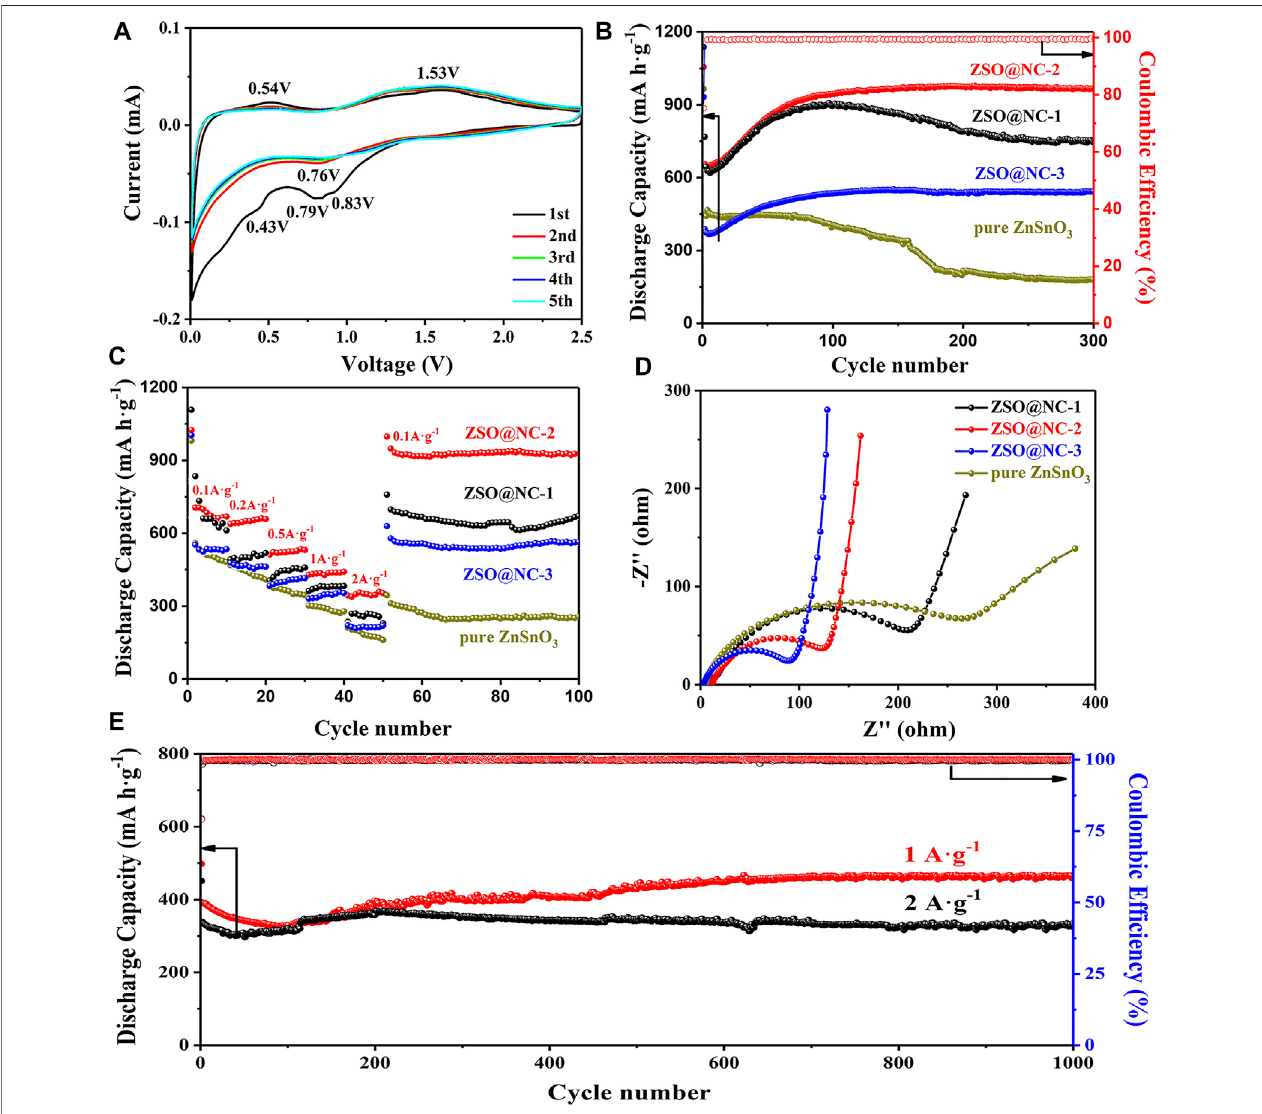
FIGURE 5 | (A) Typical CV curves of ZSO@NC-2, (B) Cyclic performance curves of ZSO@NC-(1,2,3) and pure ZnSnO 3 at 0.1 A g − 1 . (C) Speci fi c capacity versus current densities. (D) EIS curves of ZSO@NC-(1,2,3) and pure ZnSnO 3 . (E) Cyclic performance curves of ZSO@NC-2 at 1 and 2 A g − 1 .